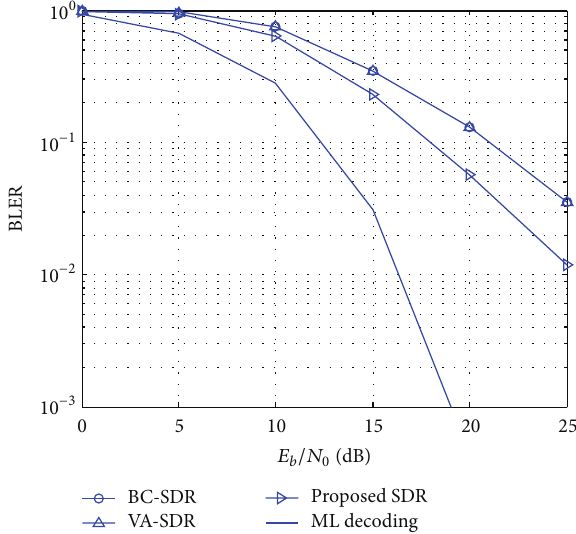
Figure 2: The BLER performance of the SDR detectors for 8 × 8 256-QAM MIMO systems.